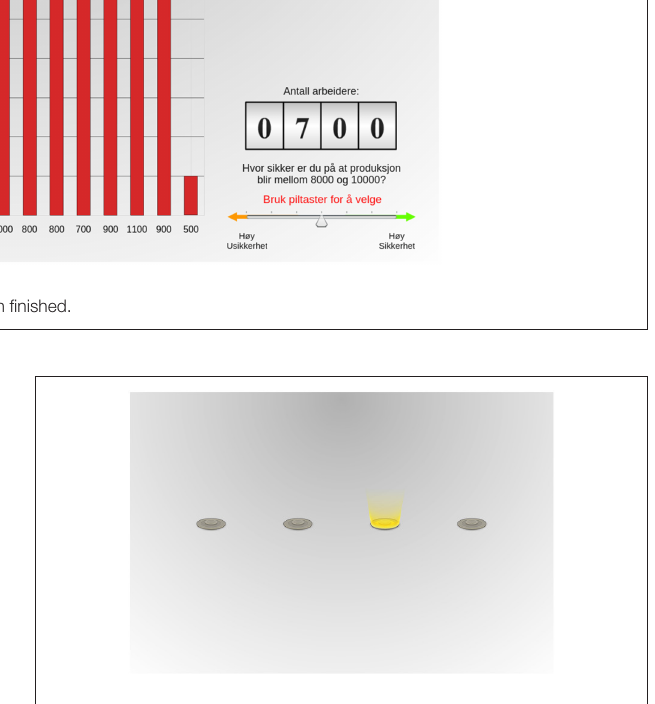
FIGURE 2 | A screenshot of the alternating serial reaction time task. The spatial goal position for the next trial is highlighted with the yellow lighting. (“Small world” art by Daniel Cook;